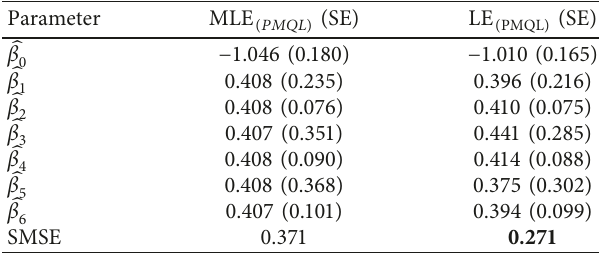
Table 12: The estimated regression coefficients, standard errors (in parentheses), SMSE values of MLE, and Liu estimator in PMQL regression model for the real data